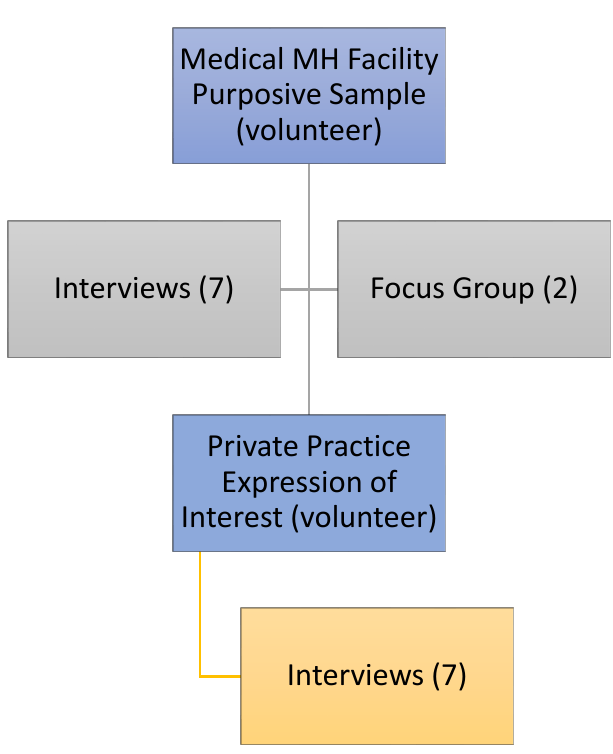
Figure 3. Flow chart of participant recruitment.